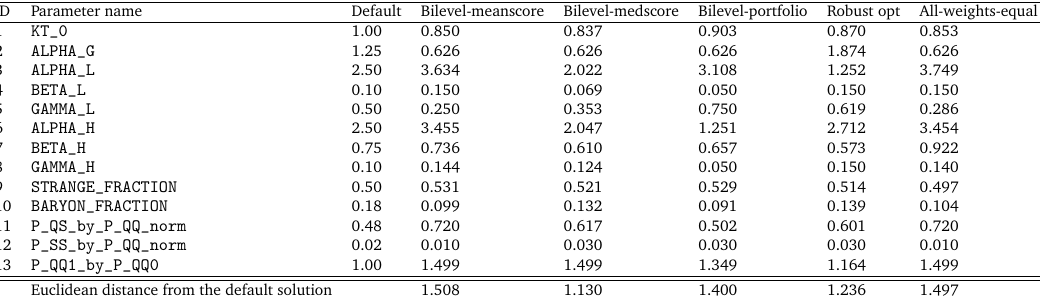
Table 27: Optimal parameter values for the S HERPA dataset obtained with all meth- ods using the cubic polynomial approximation when no filtering was applied before optimization (88